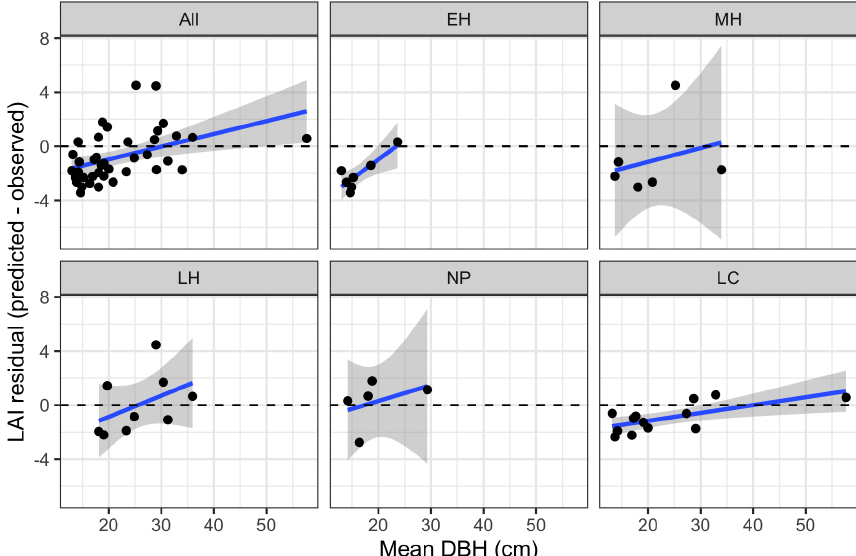
Figure 8. Bias in LAI predictions from calibrated EDR relative to observations, as a function of site mean DBH. Sites are grouped according to dominant PFT, same as in Fig. 4.